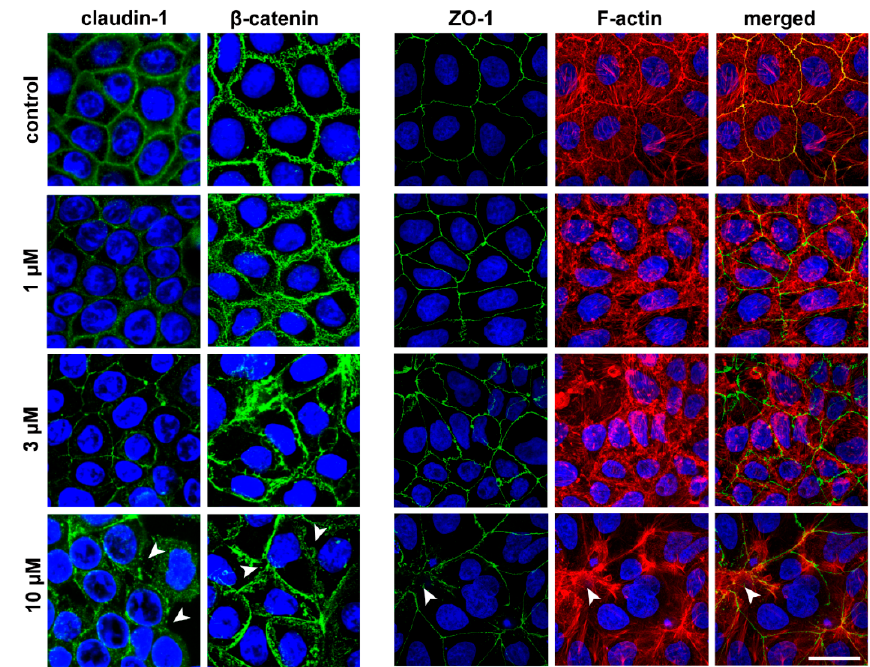
Figure 4. Effects of PN159 peptide on junctional morphology of Caco-2 cells. Immunostaining for claudin-1, β -catenin and zonula occludens-1 (ZO-1) junctional proteins and fluorescent staining for F-actin are shown in control conditions or after 1-hour peptide treatment. Green color: immunostaining for ZO-1, β -catenin and claudin-1. Blue color: staining of cell nuclei. Red color staining of F-actin. Bar = 20 µ m. Arrowheads indicate the opened junctions between the cells.